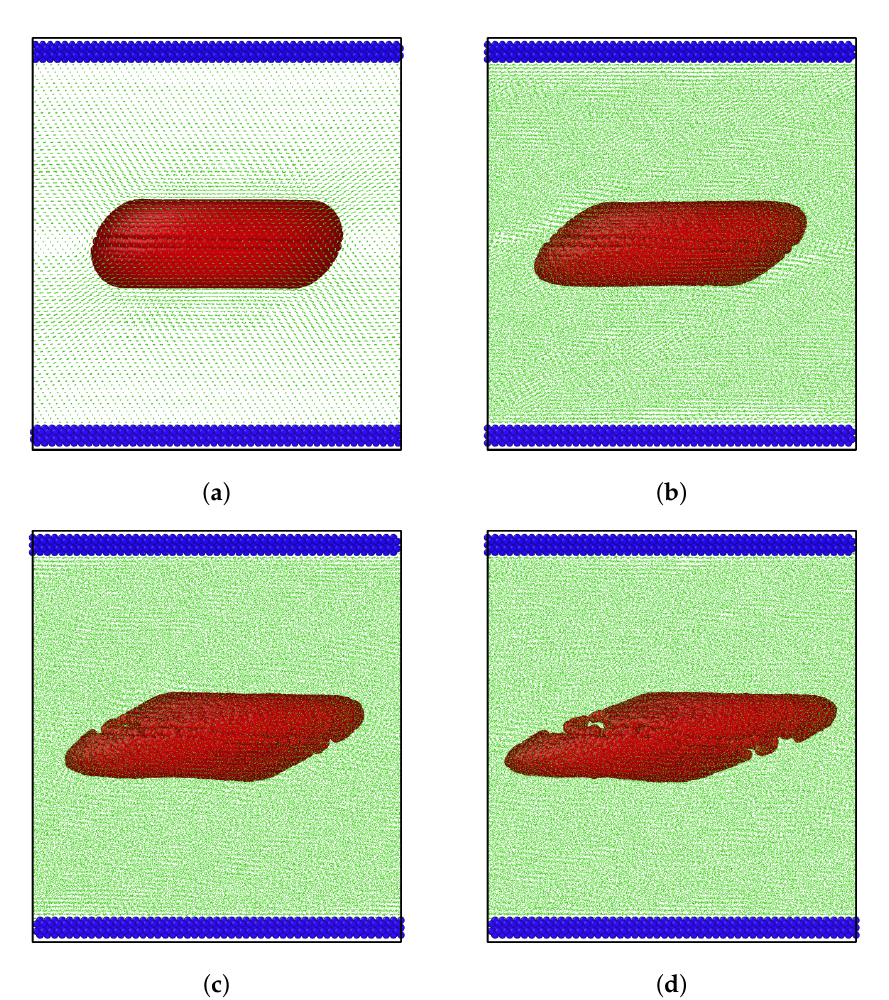
Figure 7. Rupture of the membrane under shear (Ca = 2.0) at different dimensionless times ( a ) ˙ γ t = 0, ( b ) ˙ γ t = 2, ( c ) ˙ γ t = 4, and ( d ) ˙ γ t =